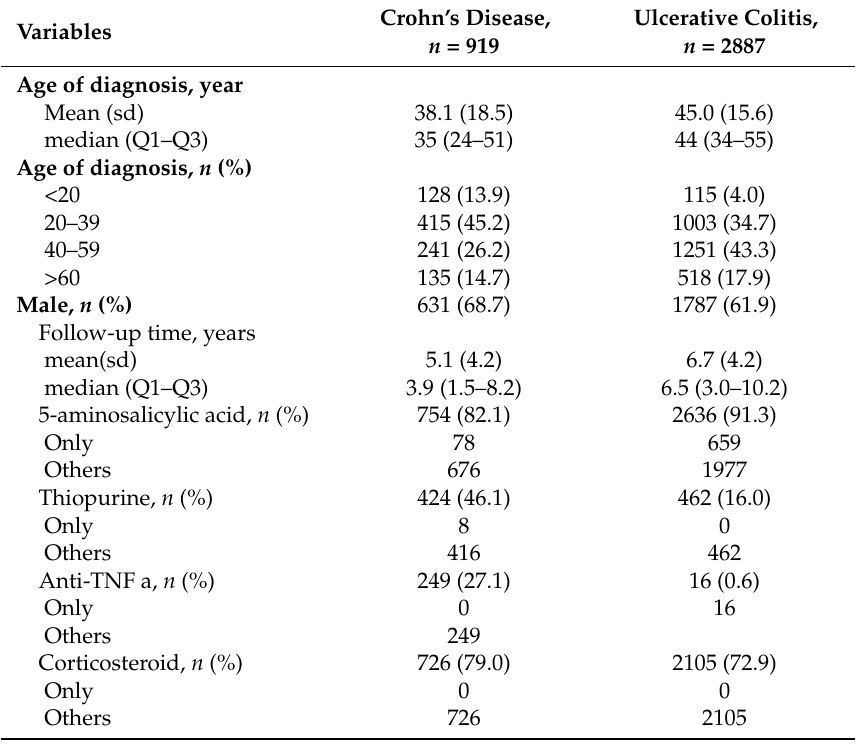
Table 1. Basic characteristics and medication distribution of patients with IBD diagnosed from 2001 to 2015.